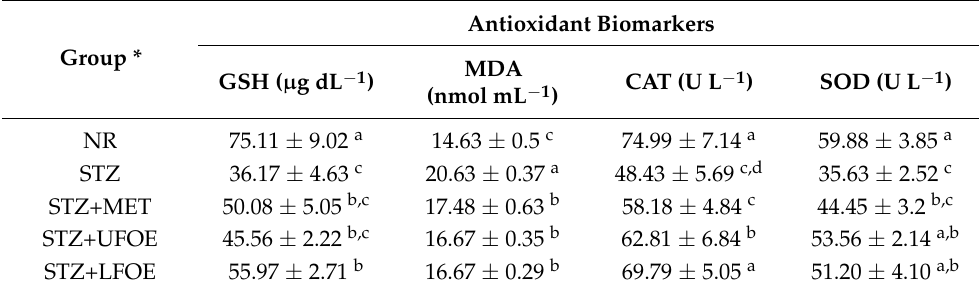
Table 8. Effect of orally administrated fermented oat extract on antioxidant biomarkers in Streptozotocin-induced diabetes in rats (mean ± SE), n =